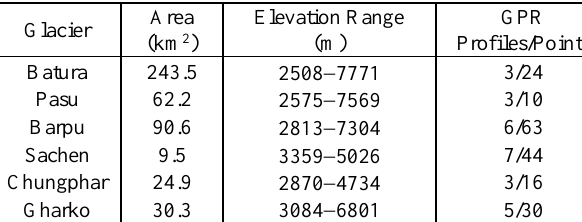
Table 1. Detail information of six observed glaciers in UIB